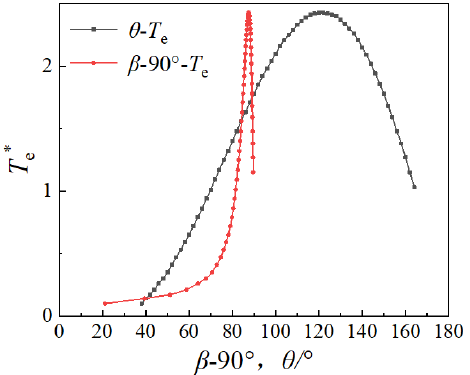
Figure 19. The curve of per unit value of torque at λ = 0.8 ρ = 20.